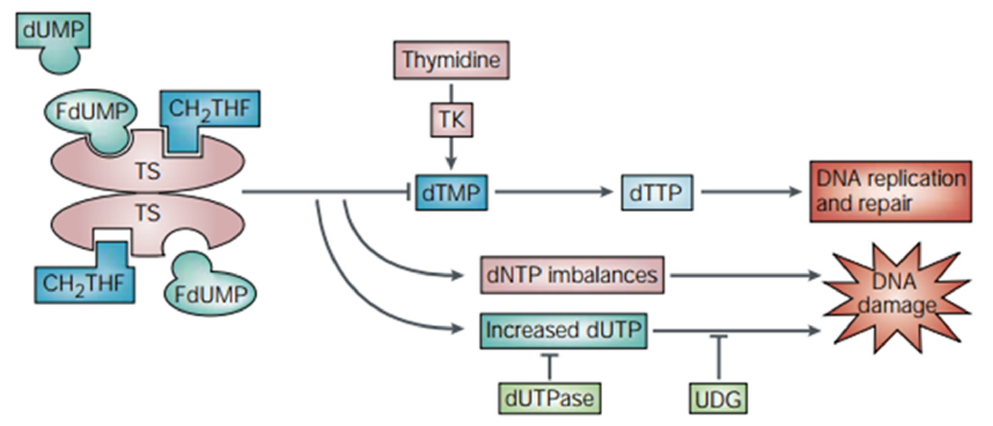
Figure 3. Mechanism of thymidylate synthase inhibition by 5-FU. TS catalyzes the conversion of dUMP to dTMP with 5,10-methylene tetrahydrofolate (CH2THF) as the methyl donor. The 5-FU active metabolite fluorodeoxyuridine monophosphate (FdUMP) forms a stable triple complex with TS and CH2THF, blocking access of dUMP to the nucleotide-binding site and inhibiting dTMP synthesis. This results in deoxynucleotide (dNTP) pool imbalances and increased levels of deoxyuridine triphosphate (dUTP), both of which cause DNA damage. The pyrophosphatase dUTPase and uracil-DNA glycosylase (UDG) affect the degree of DNA damage caused by dUTP. Thymidine kinase (TK) can promote the synthesis of dTMP. Adapted from [53].